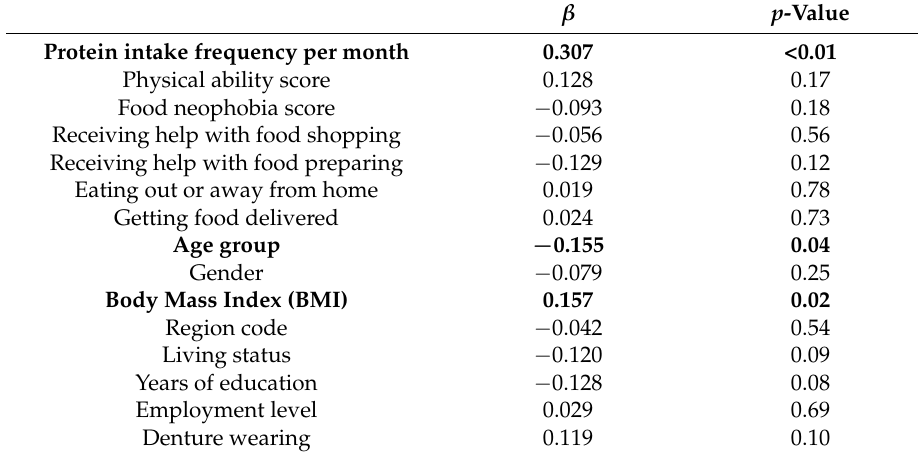
Table 4. Outcomes of the multiple linear regression model assessing the effect of demographic characteristics and lifestyle factors on egg intake. Significant effects are given in bold ( p < 0.05). β p